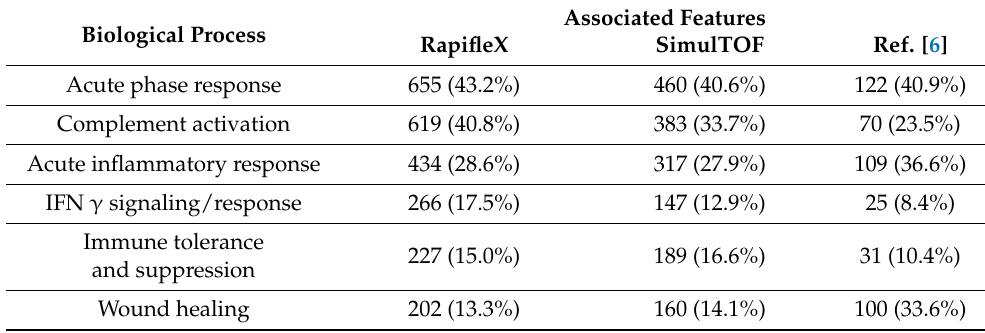
Table 2. Number of features associated with each biological process with FDR of < 5% and a p -value of association < 0.01 for 400,000 shot spectra collected on the RapifleX and SimulTOF100 mass spectrometers using the processing and feature definitions presented in this paper. A comparison is made with the number of associated features obtained with the same 400,000 shot spectra collected on the SimulTOF100 mass spectrometer using an alternative processing and feature definition method [6]. The percentages show the proportion of all analyzed features that show an association with the biological process. Note the substantial increase in the number of associated features identified when the new processing feature definition method is